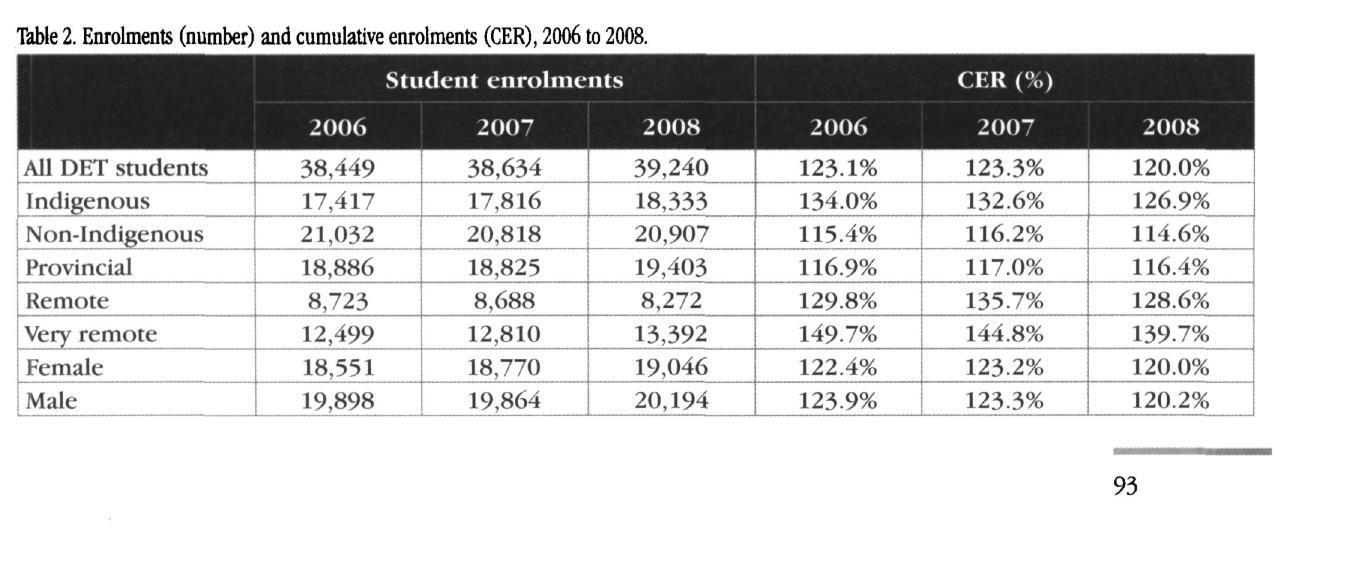
Table 2. Enrolments (number) and cumulative enrolments (CER), 2006 to 2008.